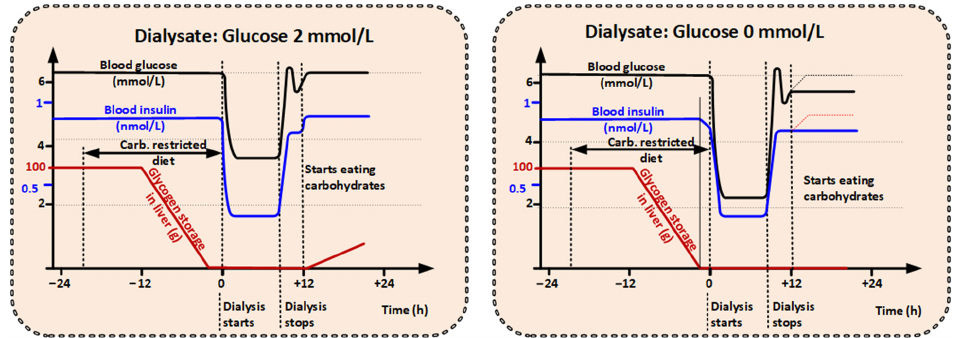
Figure 4. The dialysis simulation is utilizing a standard dialysis setting of 300 mL/min in blood flow and a 500 mL/min in dialysis fluid flow; the physiological model we have used for the simulation has been presented by Todd et al. [53,54]. When diet starts, the available glycogen level is set to 100 g in the liver [49,50,55]. When dialysis starts, the blood glucose level will fall towards 3 mmol/L if a dialysis fluid glucose concentration of 2 mmol/L is used; if the dialysis fluid glucose concentration is 0 mmol/L the simulation indicates a fall toward 2 mmol/L of glucose in the blood. Consequently, CancerDialysis can promptly switch the metabolic conditions for the cells.